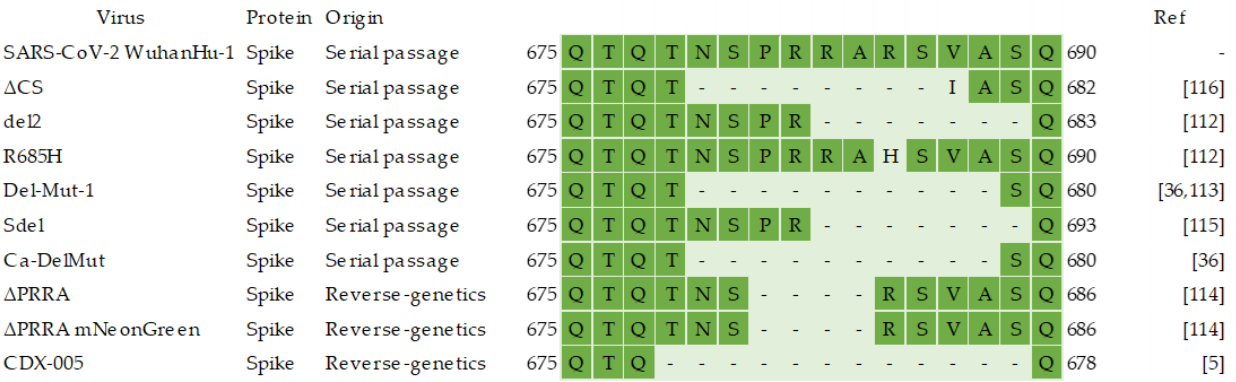
Figure 4. A comparison of the FCS deletions and substitutions in the attenuated SARS-CoV-2 viruses [5,36,112–116]. Table 2. The models of coronavirus infection identified in the included studies, excluding animals with innate and adaptive immune deficiencies.